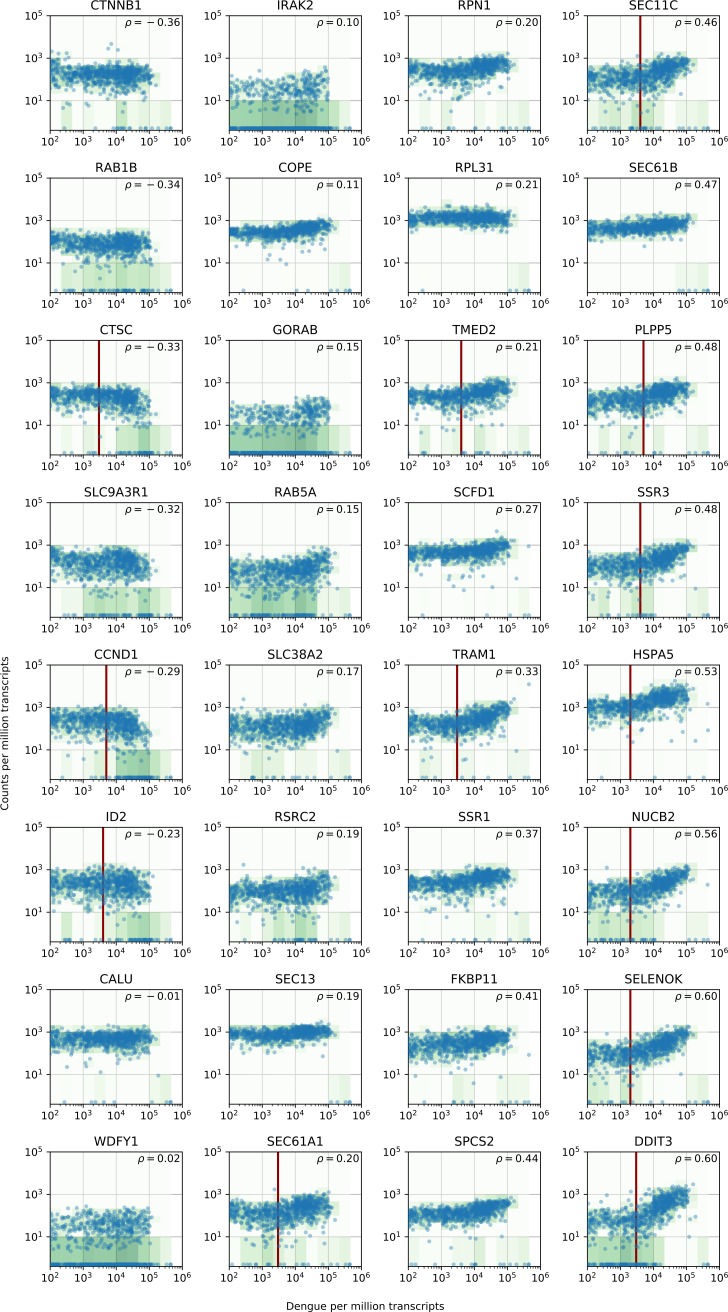
vRNA level versus gene expression across all time points and MOIs during DENV infection for 32 genes with interesting dynamics that were picked for validation via loss-of-function and gain-of-function experiments.